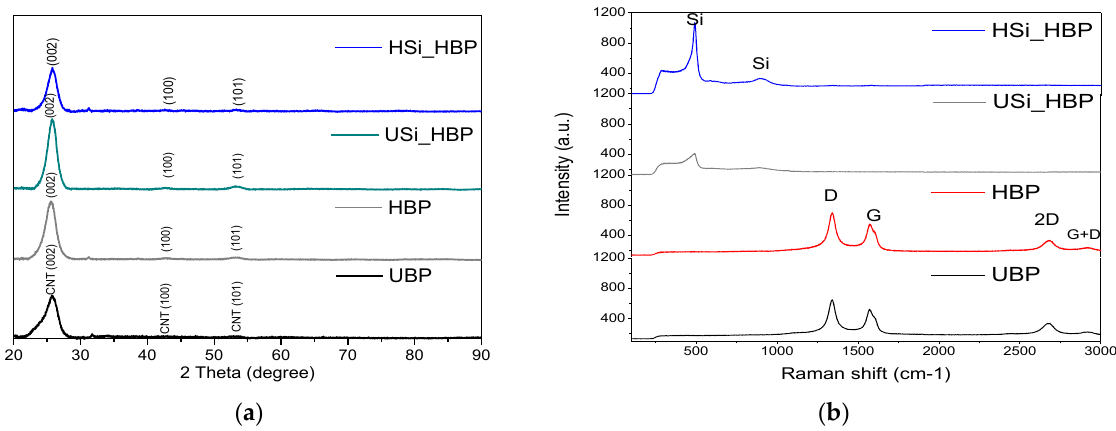
Figure 5. ( a ) XRD patterns and ( b ) Raman spectra of UBP, HBP,Si_HBP, and HSi_HBP electrodes.